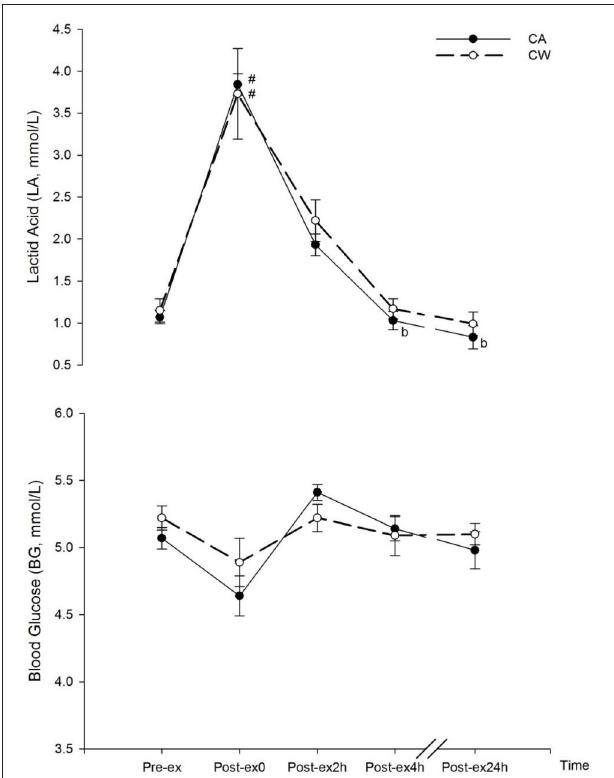
FIGURE 2 | Changes in BG and LA following main trials ( # vs. Pre-ex0: P < 0.05; b vs. Post-ex0: P < 0.05). CA, CHO + Alpha-lactalbumin; CW, CHO + Whey PRO.